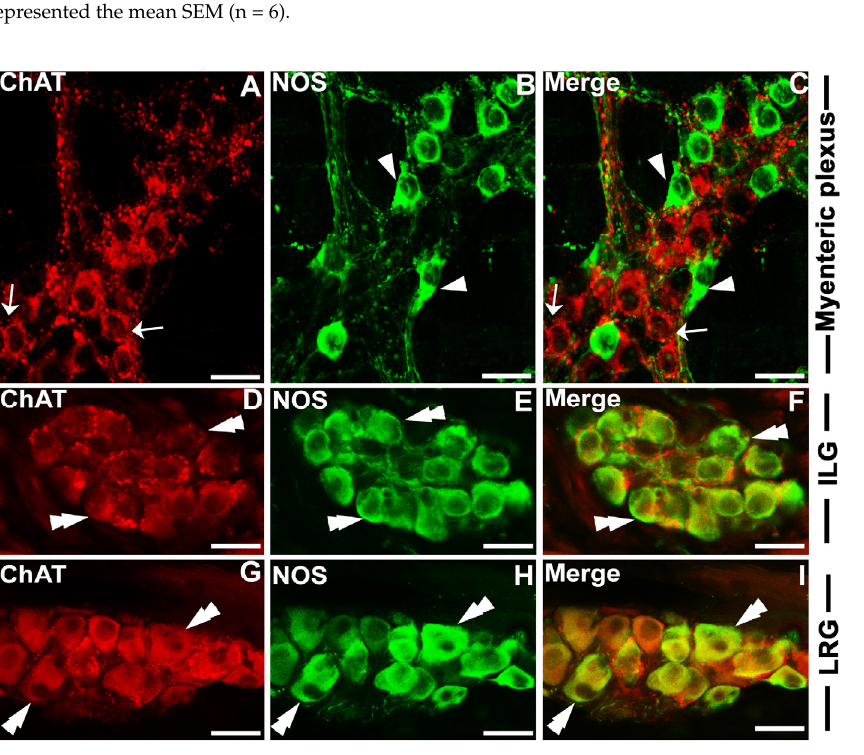
Figure 3. Double immunofluorescence histochemistry for ChAT with NOS in myenteric ganglia and lingual ganglia. Photomicrograph showing the coexpression of ChAT with NOS in the Myenteric plexus in the duodenum ( A – C ), ILG ( D – F ), and LRG ( G – I ). Cells single-positive for ChAT are indicated by arrows. Cells single-positive for NOS are indicated by arrowheads. Cells positive for both ChAT and NOS are indicated by double arrowheads. ILG, intralingual ganglion; LRG, lingual root ganglion. Scale bar = 25 µm in ( A – I ).